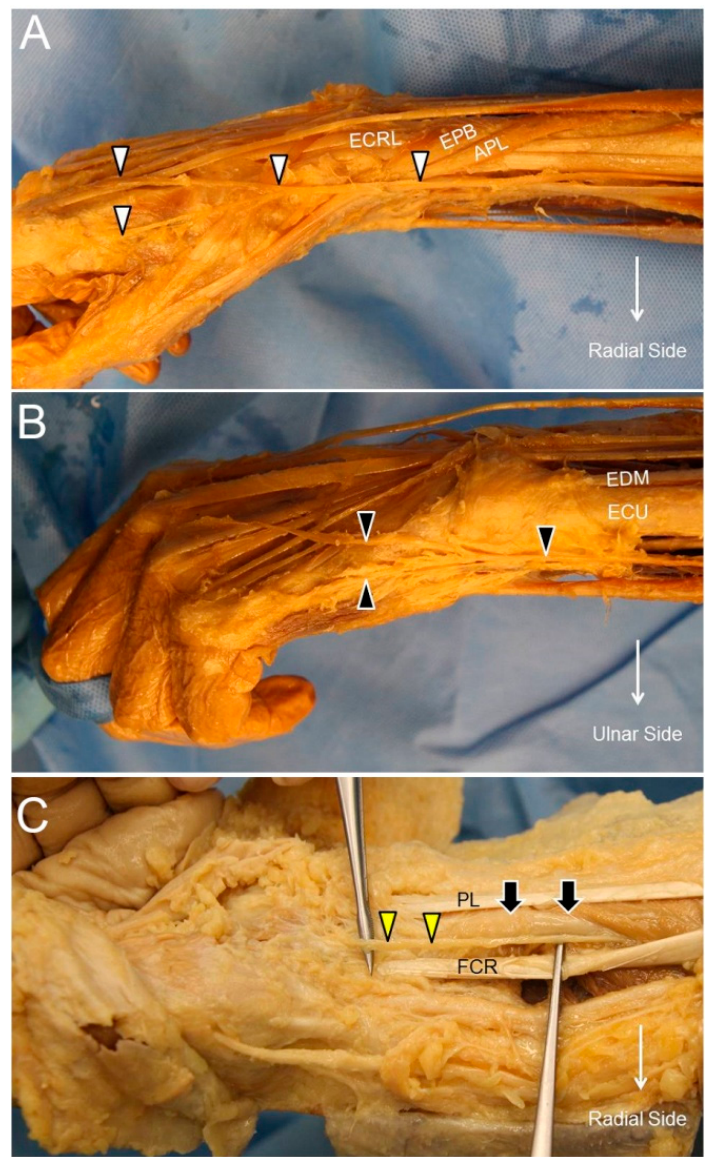
Figure 6. The superficial radial nerve (white arrowhead) (A) , the dorsal ulnar cutaneous nerve (black arrowhead) (B) , and the palmar cutaneous nerve of the median nerve (yellow arrowhead) at the distal forearm level (C) . ECRL, extensor carpi radialis longus muscle; APL, abductor pollicis longus tendon; EPB, extensor pollicis brevis tendon; ECU, extensor carpi ulnaris tendon; EDM, extensor digiti minimi tendon; PL, palmaris longus tendon; FCR, flexor carpi radialis tendon; black arrow, median nerve.